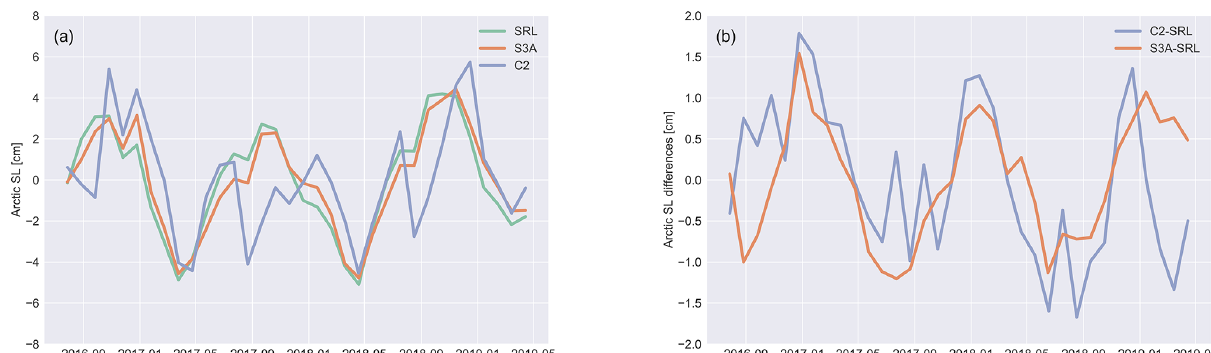
Figure 1. Time series of Arctic regional sea level for SRL, S3A and C2 (a) , as well as regional sea level differences between C2 and SRL and S3A and SRL (b)